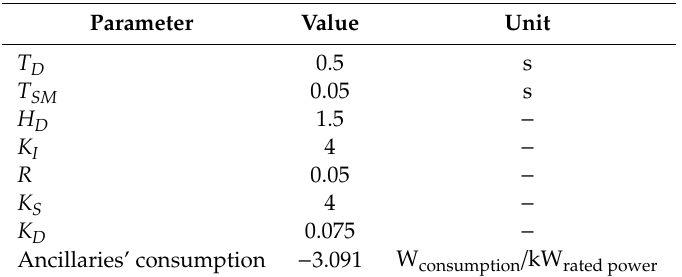
Table 6. Diesel genset